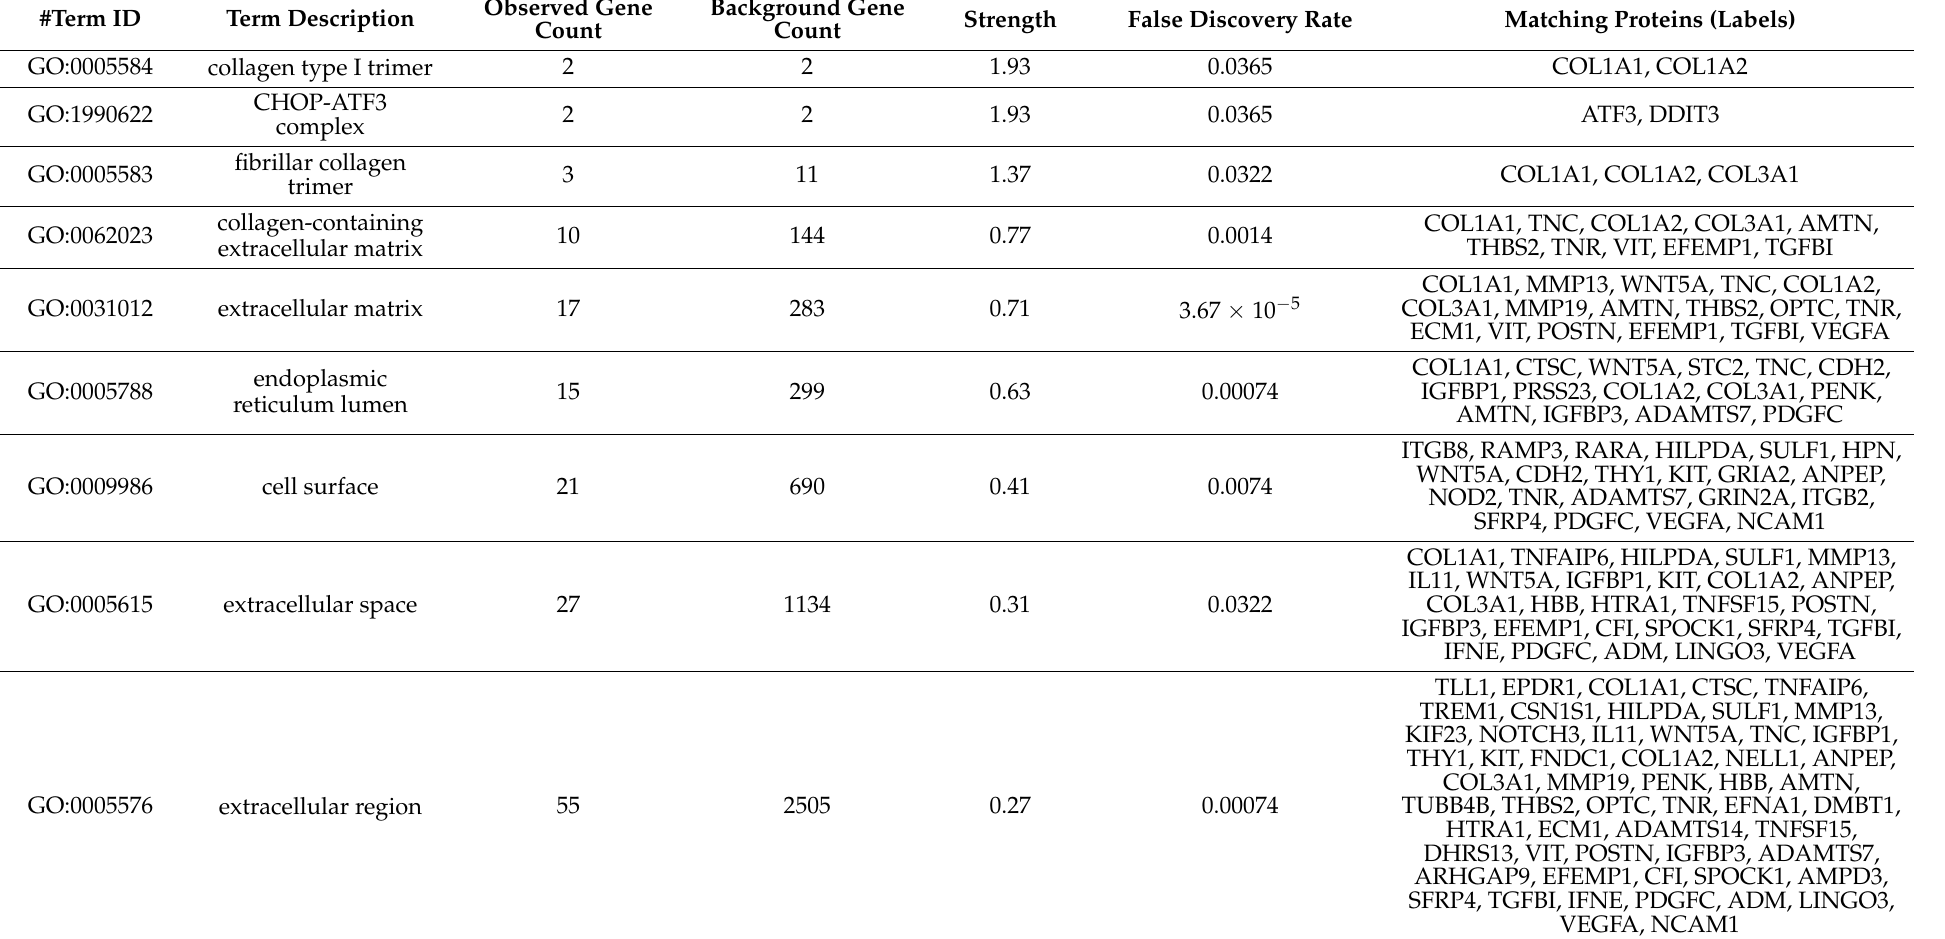
Table 2. Cellular Component enrichment